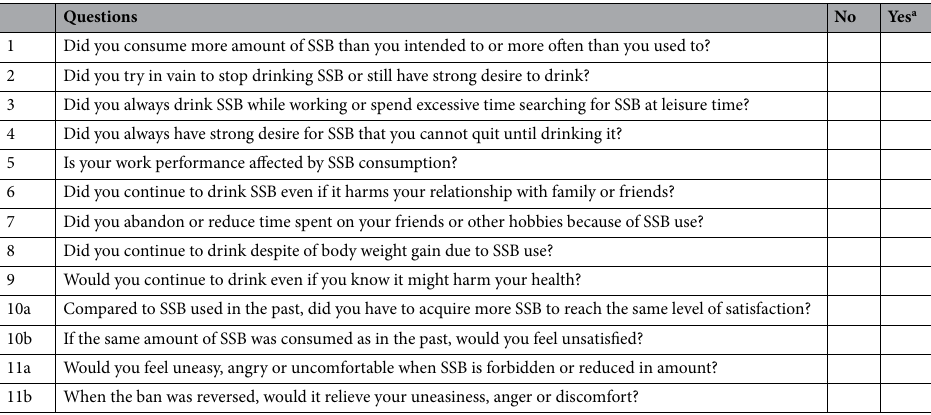
Table 2. The mean age of the cohort was 33.9 ± 4.6 years old; pre-pregnancy mean body mass index computed to be 22.7 ± 3.6 kg/cm 2 . The weight was measured in kilograms and height in centimeters on an ultrasonic elec- tronic weight and height scale in each trimester. Fifty-three point four percent of the studied group was nullipa- rous. Thirty-five percent of them reported comorbidities, including 8 hypertension, 9 overt diabetes, 14 thyroid diseases, 6 autoimmune disorders and 7 cardiovascular diseases. The highest levels of education attended were 14.1% high school, 71.2% college and 14.7% graduate school. Among the participants, 19.0% (31/163) reported no regular SSB intake, compared to 81.0% (132/163) with regular SSB use. The numbers of participants using alcohol (n = 3, 1.84%) and tobacco (n = 4, 2.45%) were minimal in this cohort. SSB use in each trimester. SSB intake behavior and numbers of positive DSM-5 symptoms in each tri- mester were presented in Table 3. Percentage of women claimed to have SSB regular intake was 81.0%, 81.6% and 84.7%; corresponding to mean SSB amount consumed of 545.1 ± 209.77 mL/day, 553.9 ± 250.27 mL/day and 563.8 ± 275.11 mL/day in the first, second and trimester, respectively. In the first trimester, 46.6% of women had ≤ 1 DSM-5 symptom, 27.0% had 2–3 symptoms, while 26.4% had ≥ 4 symptoms. In the second trimester, 49.1% of women had ≤ 1 DSM-5 symptom, 27.6% had 2–3 symptoms, while 23.3% had ≥ 4 symptoms. In the third trimester, 53.4% of women had ≤ 1 DSM-5 symptom, 20.3% had 2–3 symptoms, while 26.4% had ≥ 4 symp- toms. The mean numbers of DSM-5 symptoms in each trimester did not reach statistical significance (2.5 ± 2.25, 2.6 ± 2.45, 2.4 ± 2.43 symptoms for the first, second and third trimesters, respectively, p = 0.750).